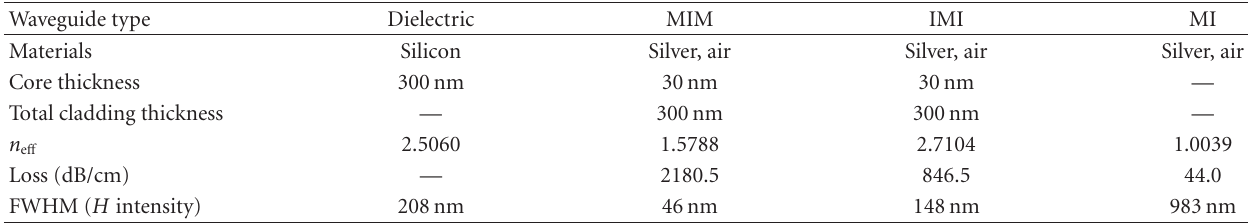
Table 3: TM-mode size comparison for dielectric and plasmonic waveguides with λ = 1550 nm light. Data acquired from FDTD Solutions’s integrated mode solver